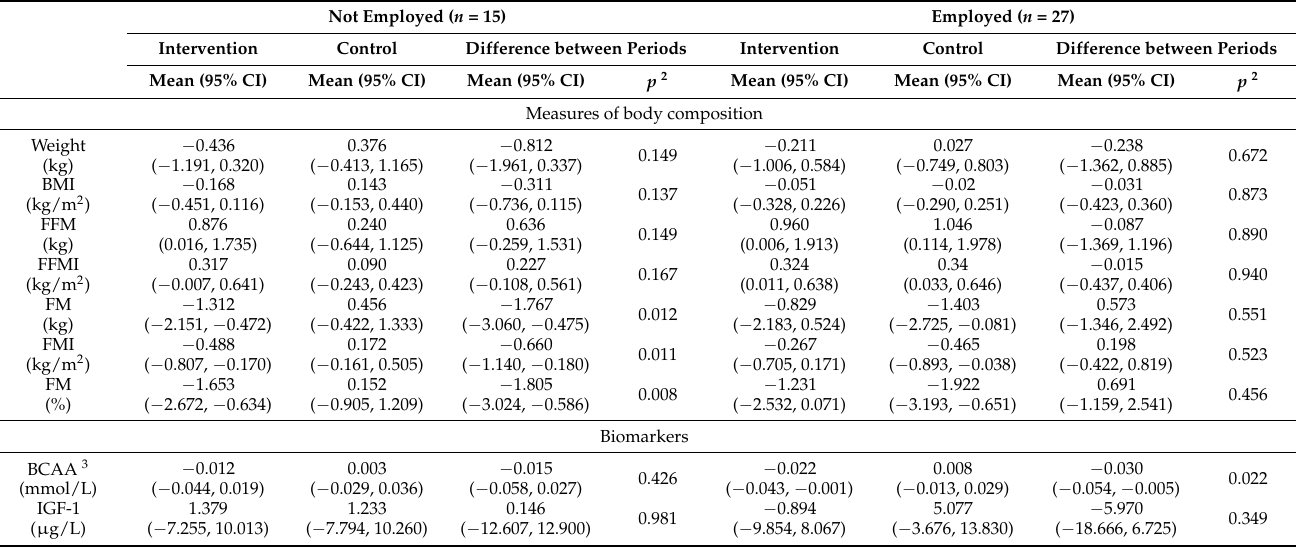
Table 2. Modelled estimates of differences in body composition, and metabolic markers hypothetically related to body composition, between intervention and control diet periods among patients with RA in the ADIRA trial stratified by employment status 1